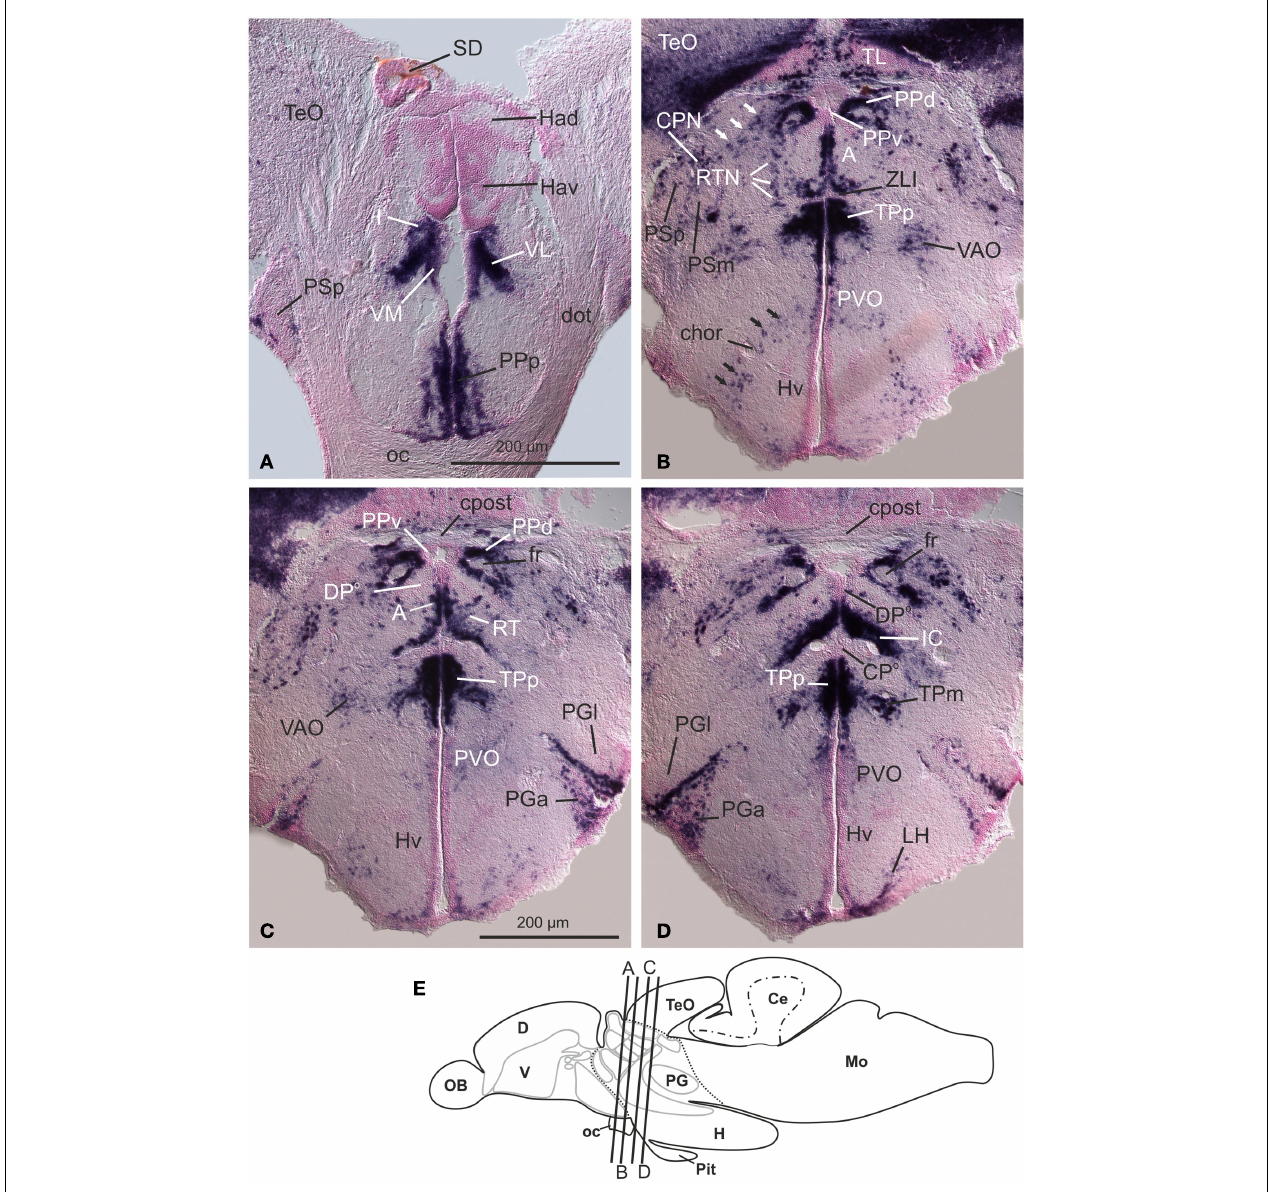
dorsoposterior (DP o ) and centroposterior (CP o ) nuclei, are predominantly glutamatergic and GAD67 -negative. However, some dorsal thalamic nuclei close to the ZLI are also GABAergic and likely derivatives of the rostral thalamus proper (rTh).These are the anterior (A,B) and the intercalated nucleus [IC; (D) ]. (E) Schematic drawing of the zebrafish brain that indicates the approximate position of transverse sections. From Mueller and Guo (2009). Abbreviations see